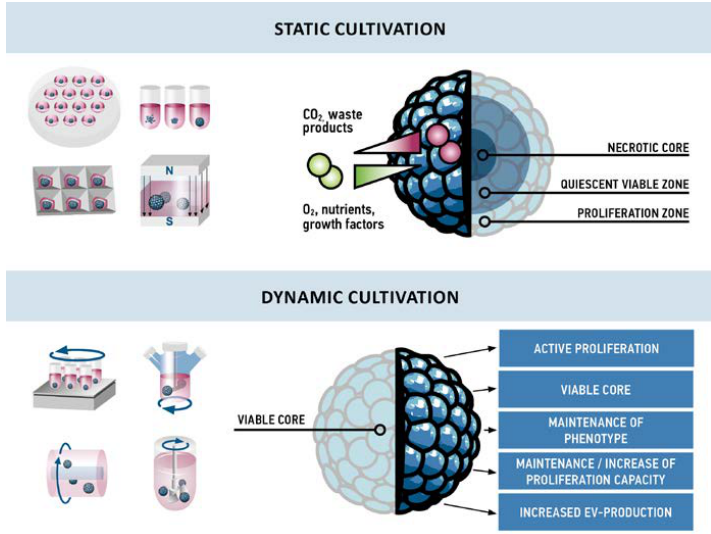
Figure 3. Comparison of effects observed in static and dynamic cultivation of MSC aggregates. Due to gradients of nutrients and waste products, aggregates cultivated under static conditions are usually structured in three layers: a necrotic core in the center, a quiescent viable zone of non-proliferative cells, and an outer layer with proliferating cells. In contrast, dynamic cultivation conditions result in a viable core and active proliferation throughout the aggregate. Cells from these aggregates maintain their phenotype, proliferation capacity, and display an increased production of